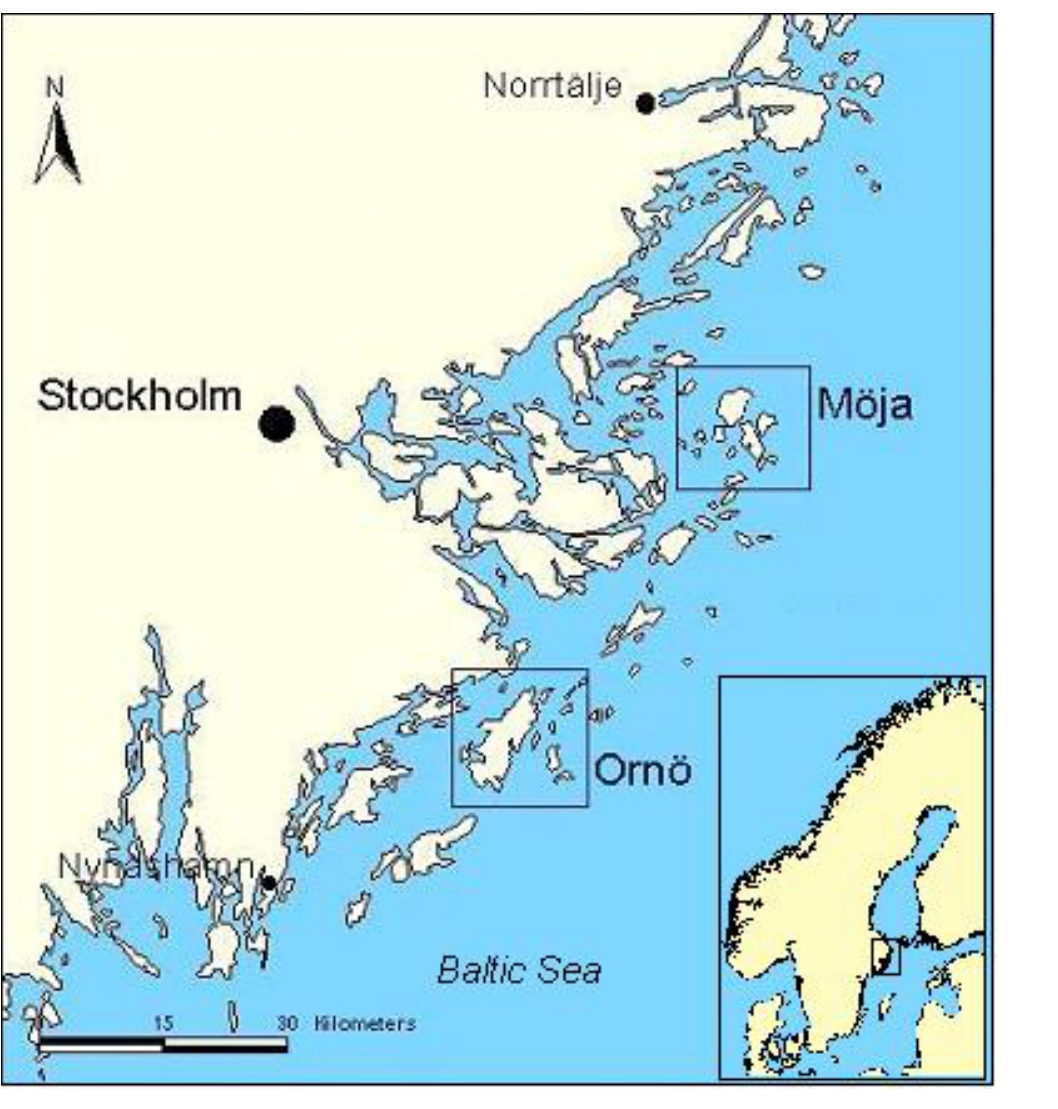
Fig. 1 . Stockholm Archipelago, Sweden, showing the coastline and the two casestudy areas, Möja parish and Ornö